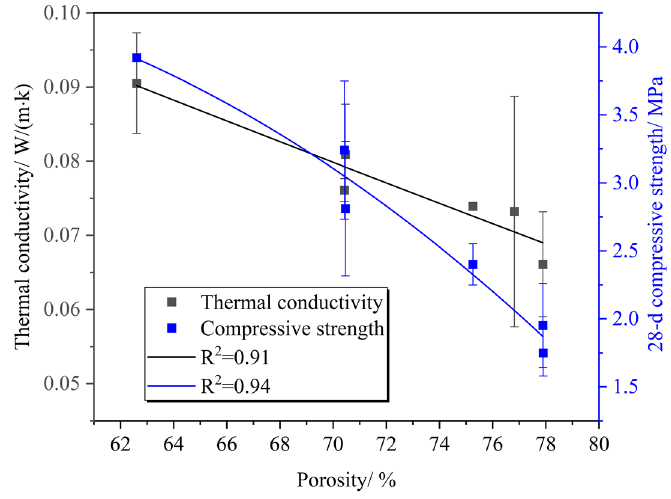
Figure 5. Relationship between the thermal conductivity and 28 d compressive strength and porosity.